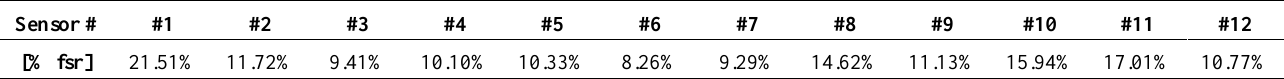
Table 2. Hysteresis in percentage of the full-scale range of the sensitive